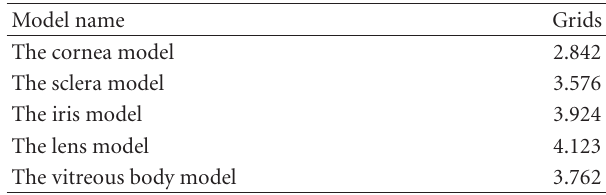
Table 1: Grids (FE elements) of the constructed